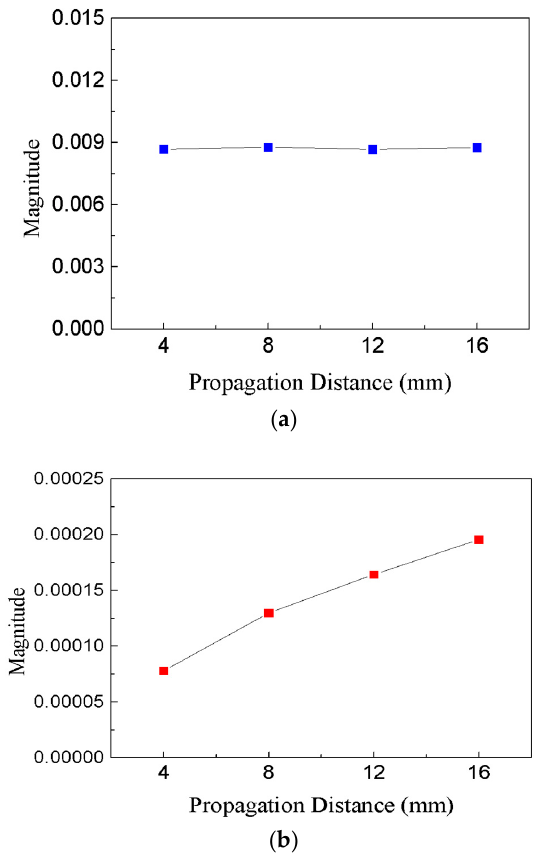
Figure 9. Magnitudes of ( a ) fundamental harmonics and ( b ) second harmonics (collected at position 1) versus the propagation distance.